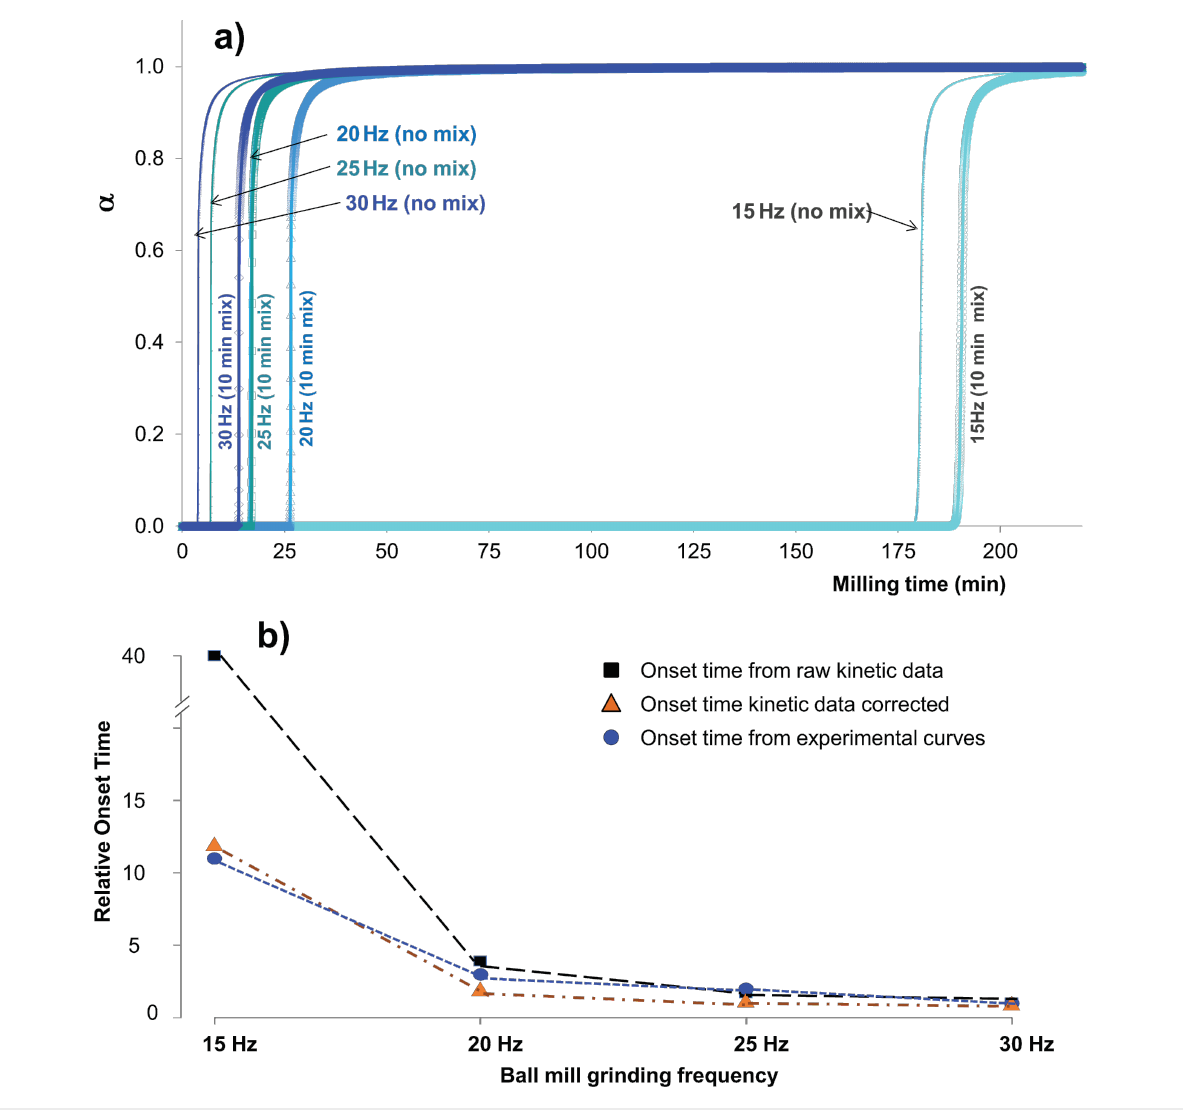
Figure 2: Reaction profiles for mechanochemical milling according to Equation 4. (a) Kinetic profiles for 30 Hz, 25 Hz, 20 Hz and 15 Hz NG milling. Raw (fine line curves) and corrected (base onset time + 10 min; thick line curves) are given and labelled. Onset time (normalized relative to 30 Hz model data) correction approximated from experimental curves. (b) Comparison of relative conversion onset times from raw kinetic curves (black rectangles), onset time corrected (brown triangles), and from experimental ball mill NG curves (blue circles) in Figure 1. E 0 : τ =